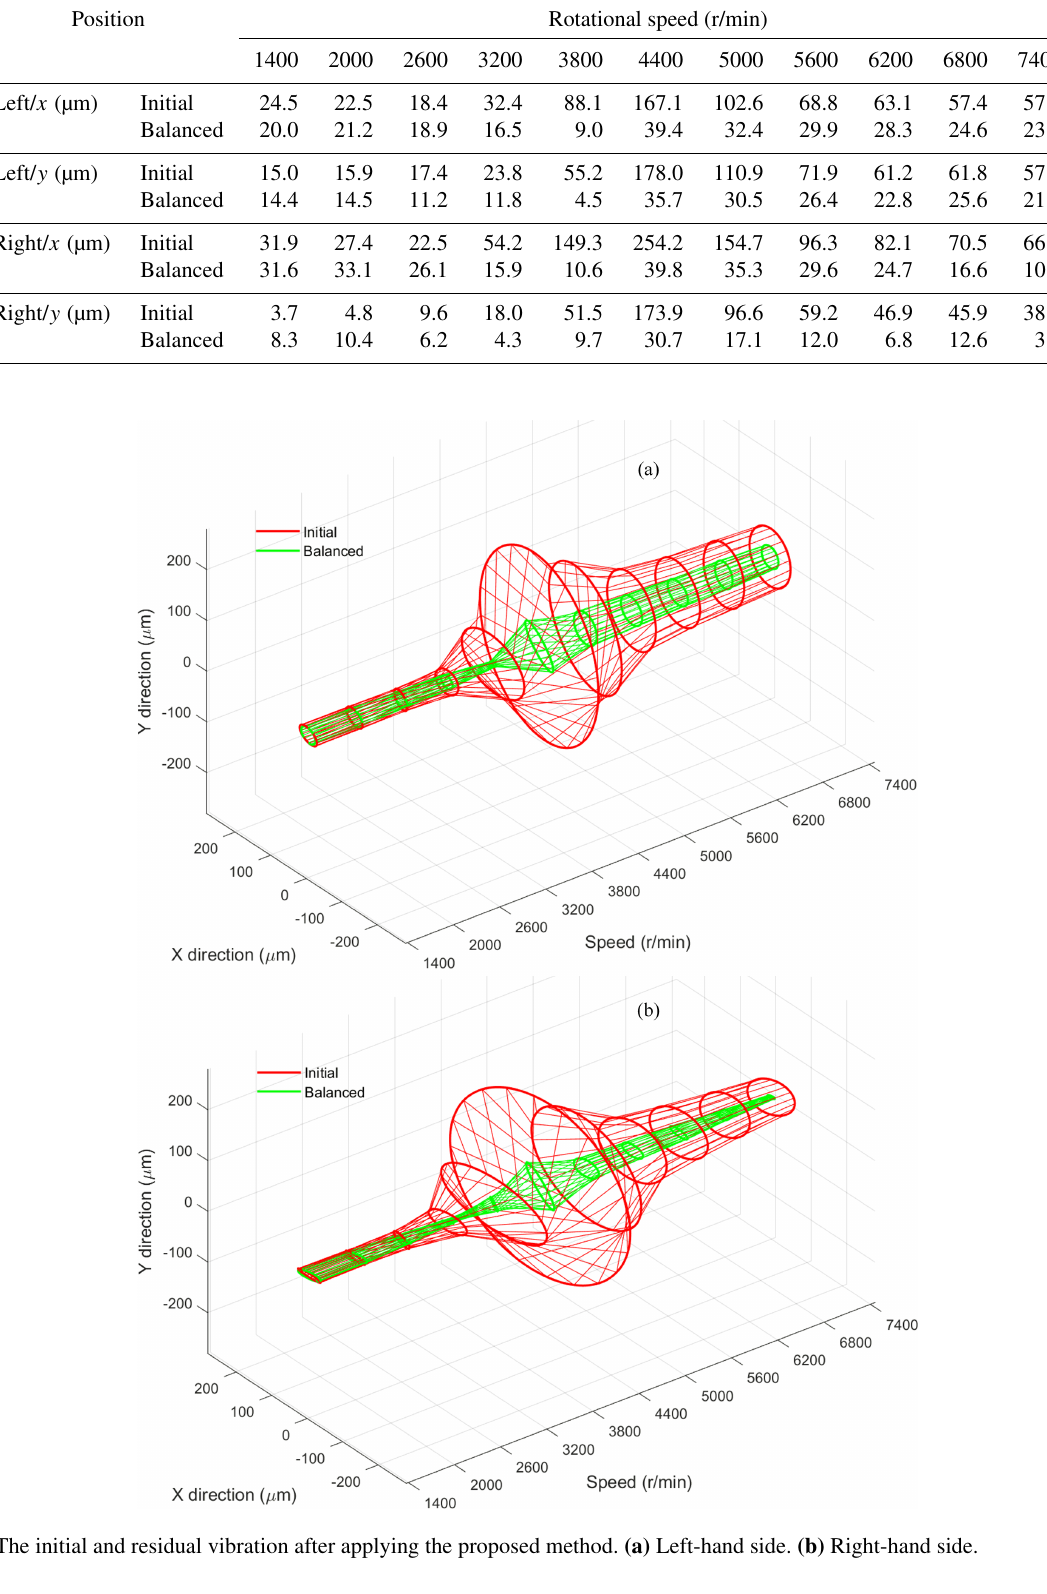
Mech. Sci., 12, 85–96,